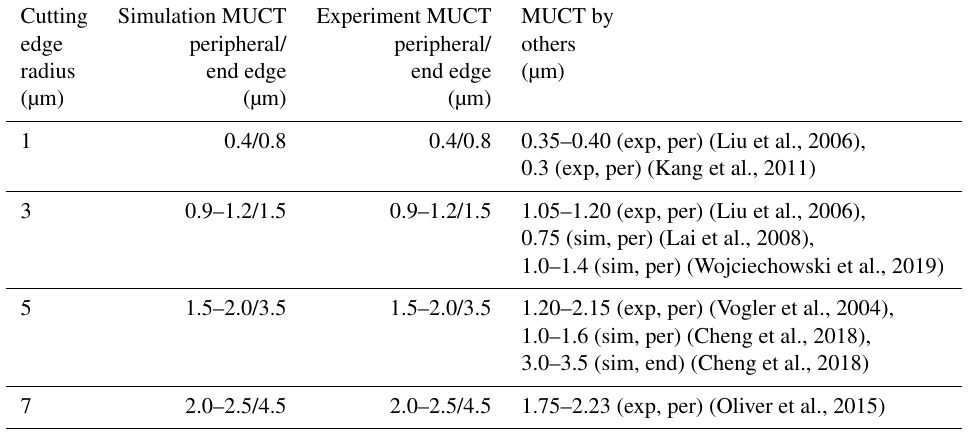
Table 9. MUCT values’ discrepancy with other articles’